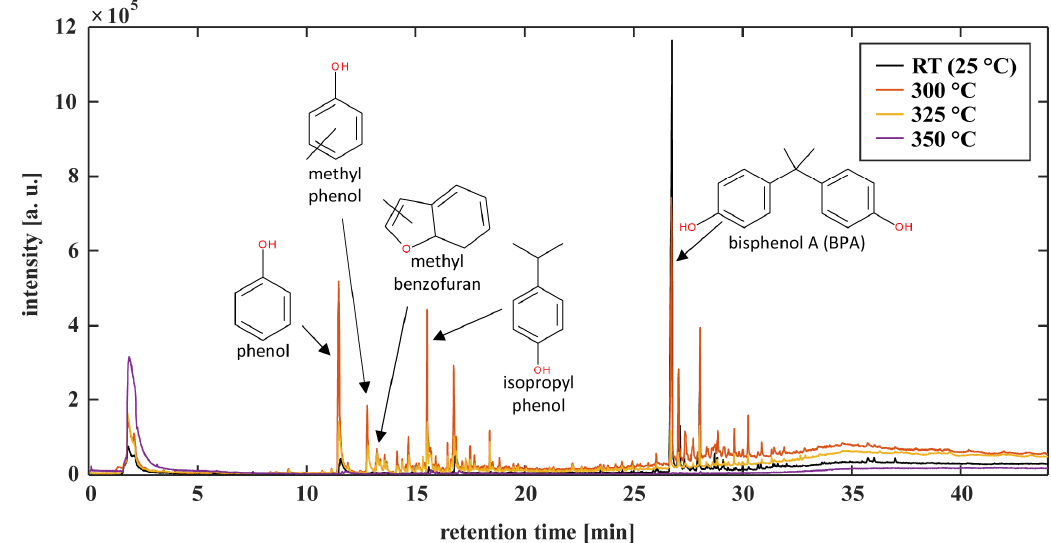
Figure 2. Total ion count (TIC) chromatogram of reinforcement material mechanically separated from thermally stressed C 3 (RT (25 °C), 300, 325, 350 °C) measured by Py-GC-EI-QMS. Exposure to room temperature leads to characteristic larger pyrolysis fragments, e.g., BPA derivatives, at higher retention times. C 3 exposed to higher temperatures shows a variety of additional smaller compounds at 300 and 325 °C, e.g., phenol derivatives, homologous of benzene, and other methoxyphenols, and a drastic decrease in detected compounds at 350 °C.